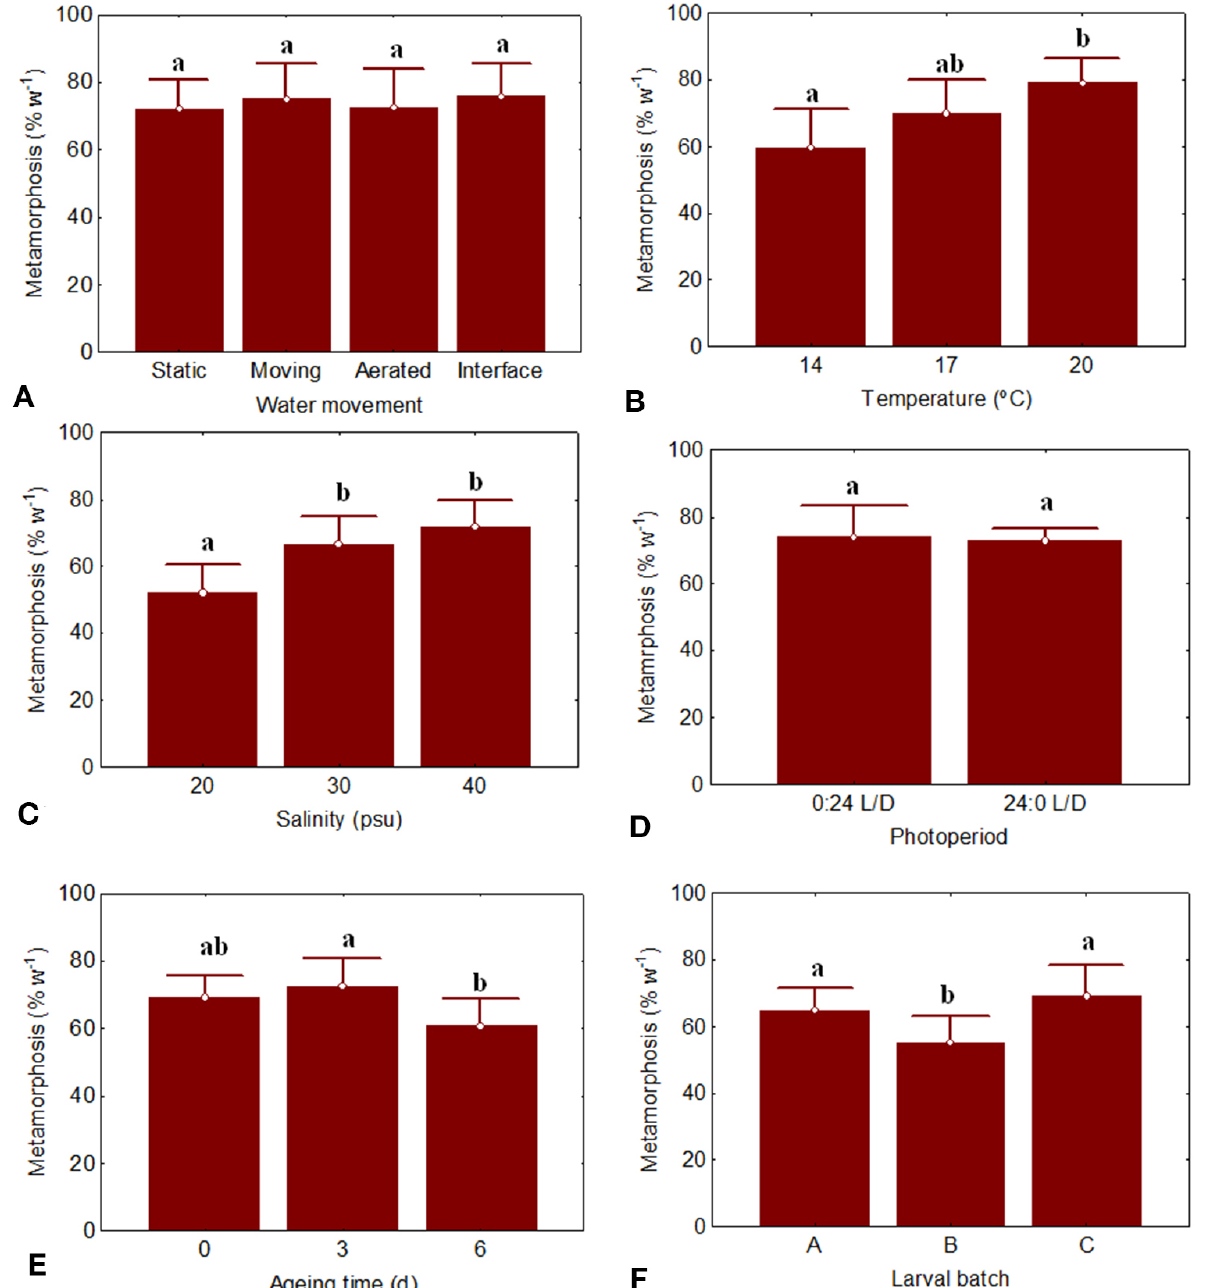
Fig. 3. – Metamorphosis (% w –1 ; mean±SE) of P. pollicipes larva allowed to settle on the adults in culture under various environmental conditions of hydrodynamics (A), temperature (B), salinity (C) and light (D), as well the cyprid-related factors of cyprid age (E) and batch origin (F). Hydrodynamic conditions tested (a) were as follows: (static) no water movement, (moving) circular water movement, (aerated) water kept under constant aeration and (interface) surface not fully submerged, but with interface between air and water. Temperature tested (B) included 14, 17 and 20°C, and salinities (C) were 20, 30 and 40 psu. Light treatments (D) were as follows: (0) 0:24 L/D photo- period on a no-choice assay; (1) 24/0 L/D photoperiod, created by all surrounding light, in a no-choice assay; (2) 24:0 L/D photoperiod, created with a single light source, on a double-choice assay between the side directly exposed to light ( light ) and the side shaded from light ( shade ). Cyprid ageing (E) was done for 0, 3 and 6 days and batches tested (F) were collected from adults during the breeding seasons of 2011 (A), 2012 (B) and 2013